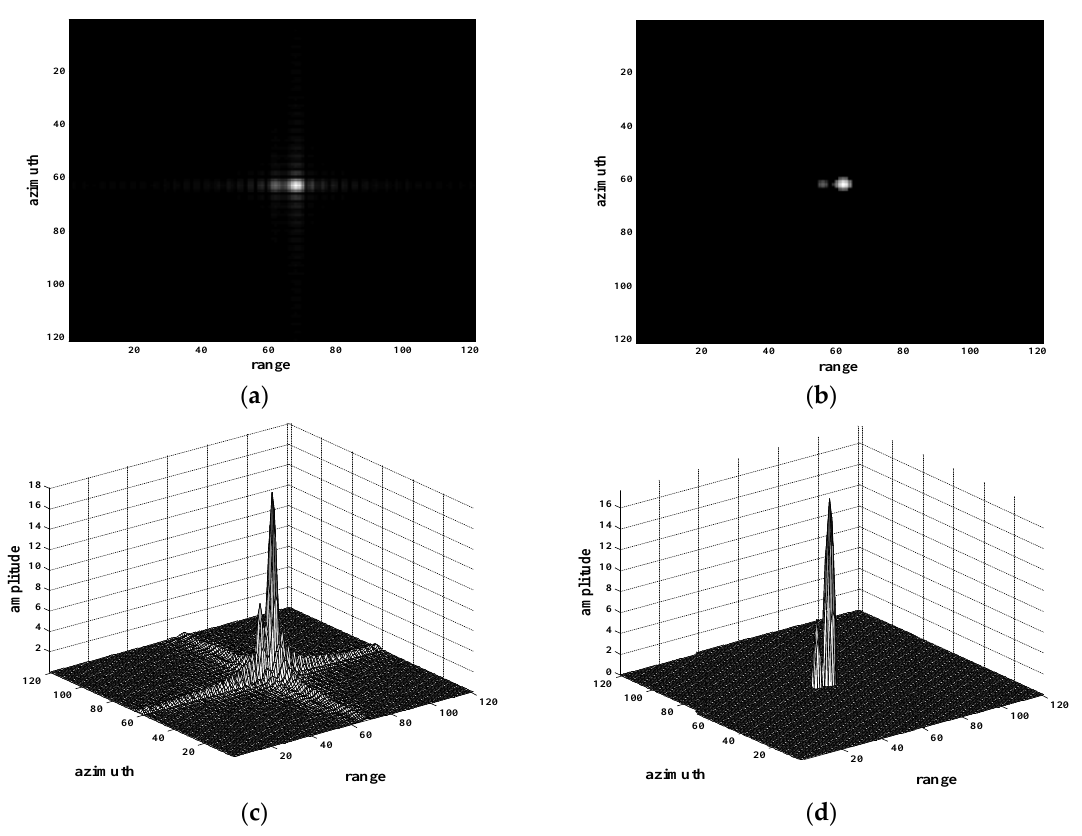
Figure 4. Experiment of two point targets, one of which is partly masked by sidelobes of the other ( a ) Imaging result of two point targets through a conventional MF-based algorithm; ( b ) Reconstructed image of (a) through the proposed method; ( c ) Three-dimensional map of two point targets in (a); ( d ) Three-dimensional map of the reconstructed image in (b).